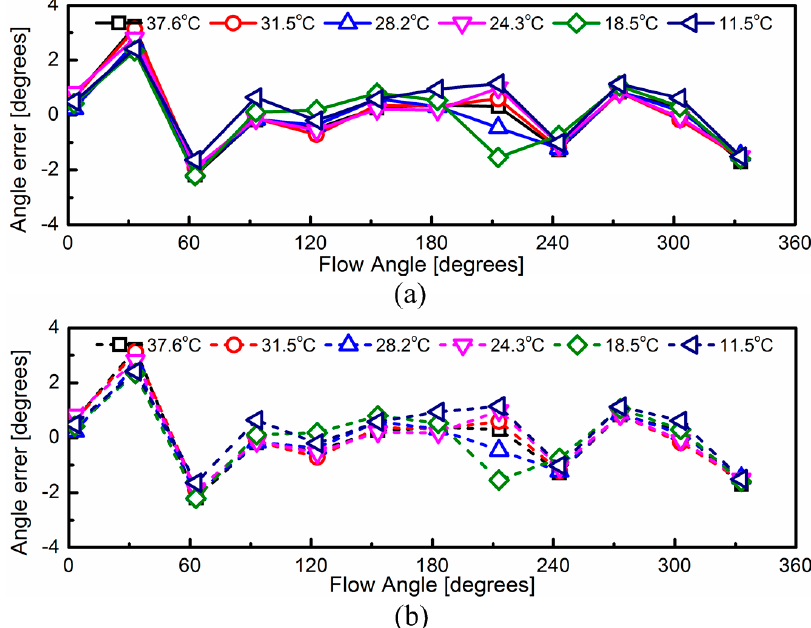
Figure 11. ( a ) The wind speed direction before considering the temperature dependence of the output signals; ( b ) The wind speed direction after considering the temperature dependence of the output signals.